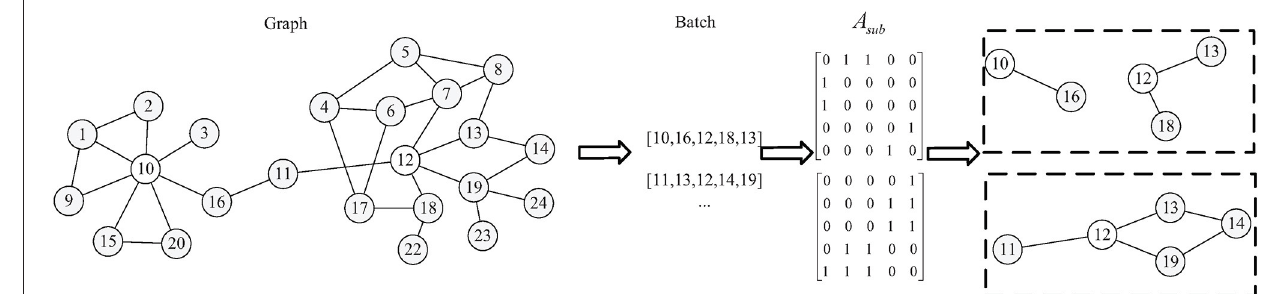
FIGURE 4 | Illustration of the